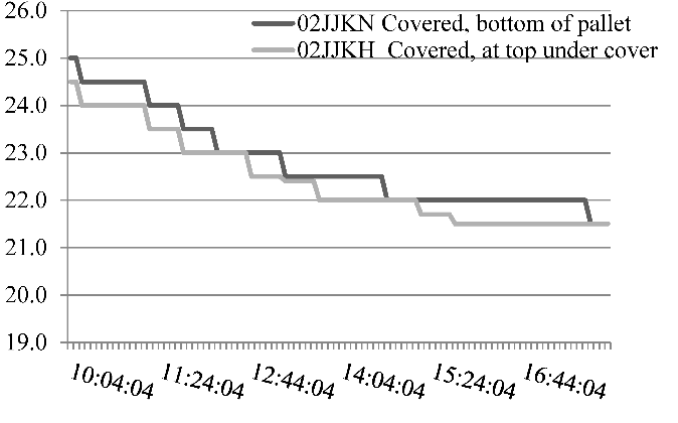
Figure 6. Temperatures at the top and bottom of the covered pallet of stored amaranth over a 6 h period on 26 February